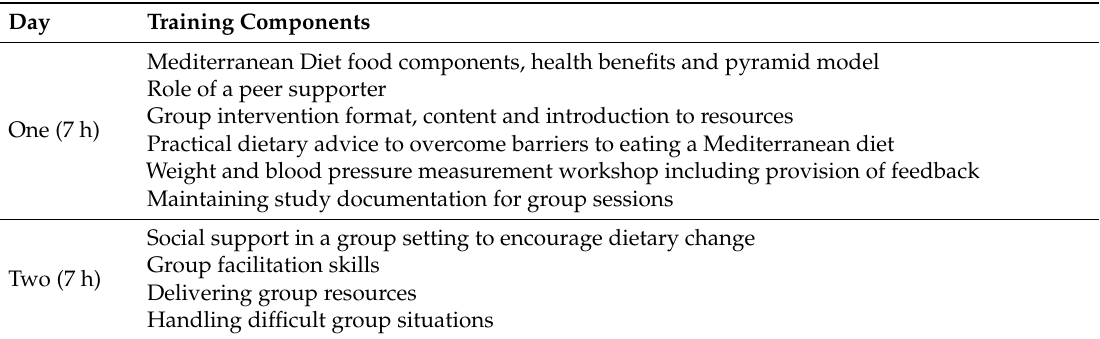
Table 2. Overview of Peer supporter training programme delivered over two consecutive